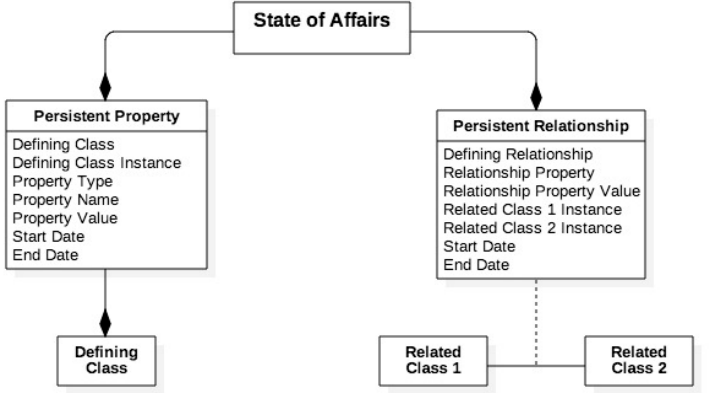
Figure 6. State of Affairs Internal Composition. A State of Affairs is determined by one or more Persistent Properties or Persistent Relationships. The relevant properties or relationships belong to one or more classes that exist within the Target Past.